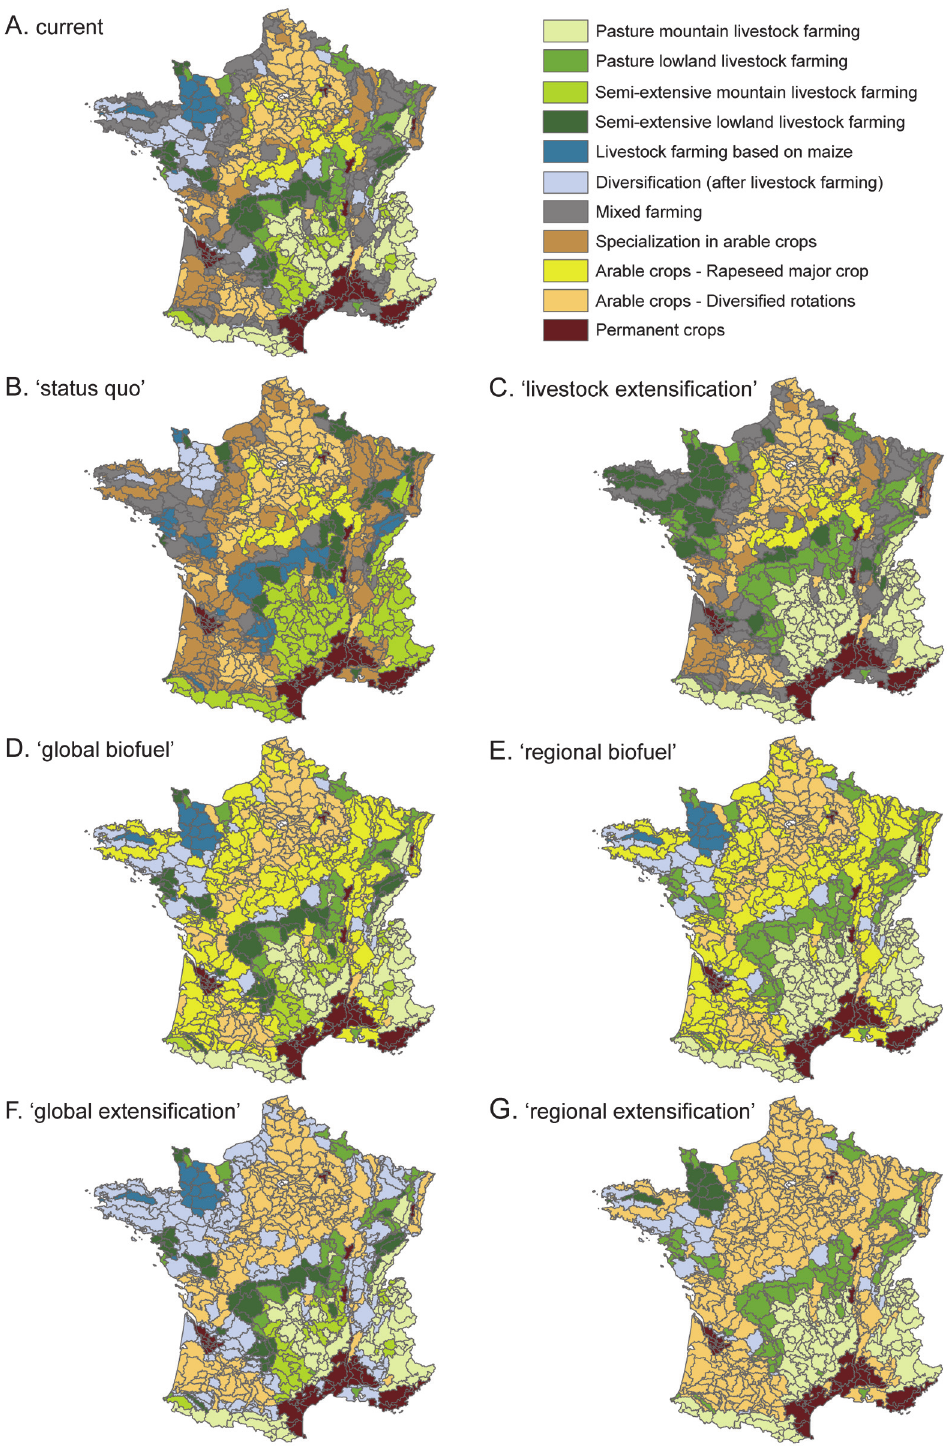
Fig 1. Typology of the main agroecosystems at the scale of small agricultural regions (SAR) in France. (A) Current distribution of main agroecosystems and (B-G) future distribution of main agroecosystems in 2050 according to the six different farmland cover scenarios.